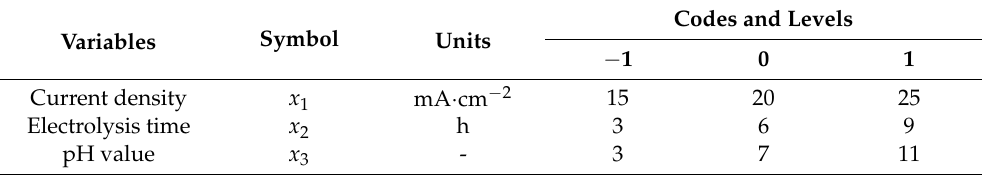
Table 2. Level and code of experimental variables based on BBD. Variables Symbol